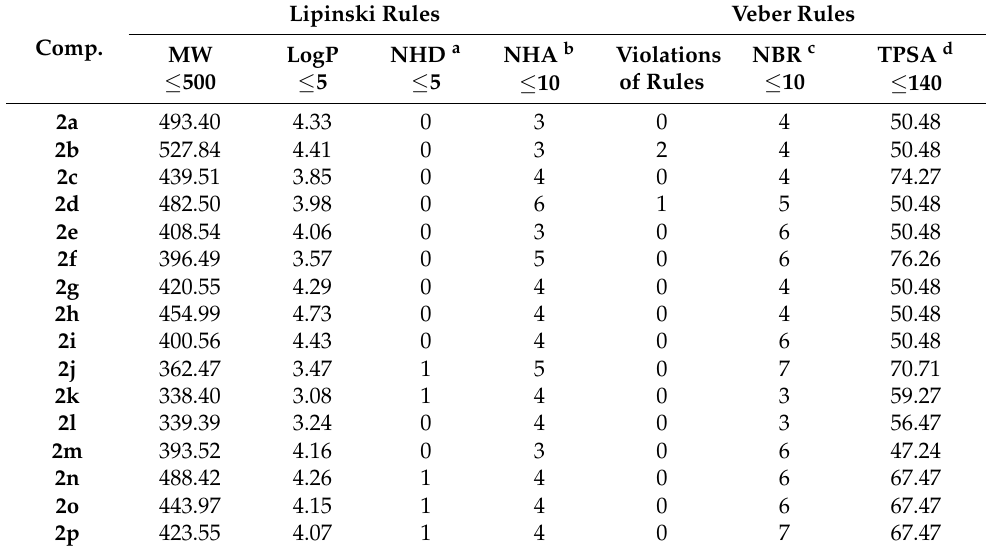
Table 3. Drug-likeness parameters, according to Lipinski and Veber rules.